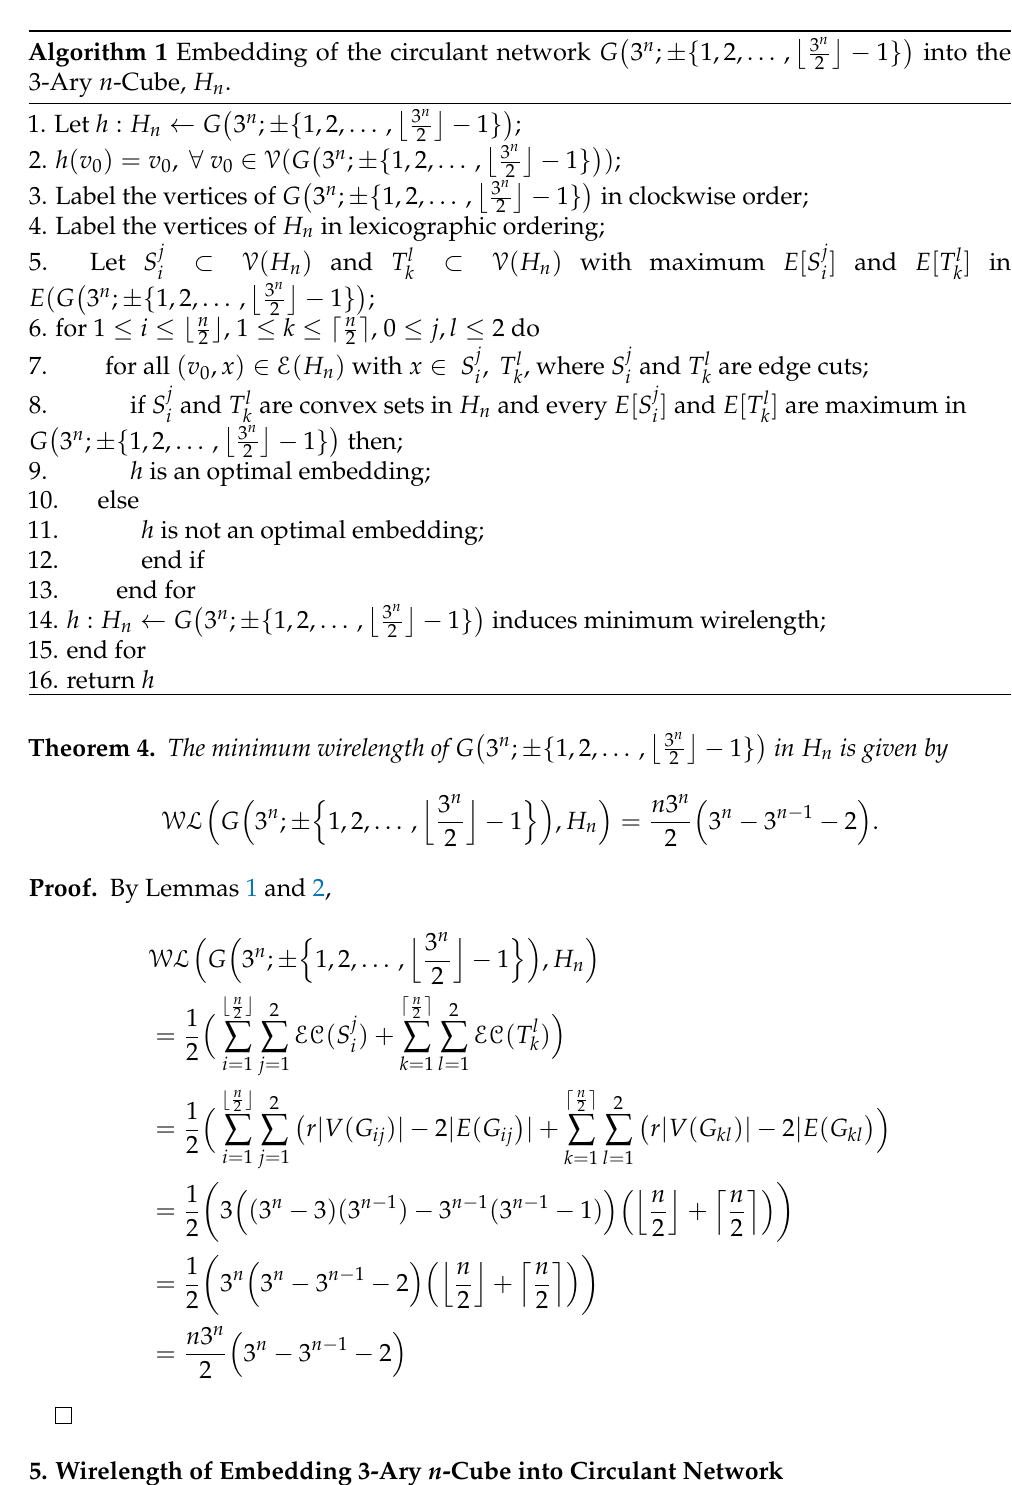
Algorithm 1 Embedding of the circulant network G